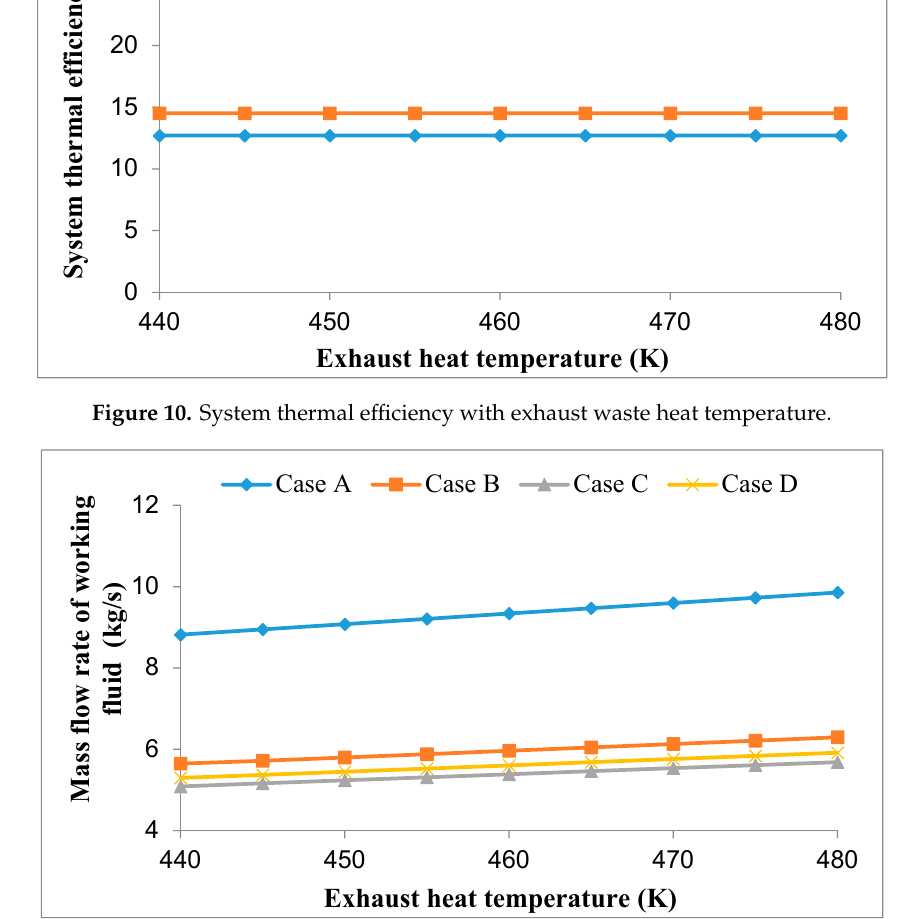
Figure 11. Mass flow rate according to exhaust waste heat temperature.